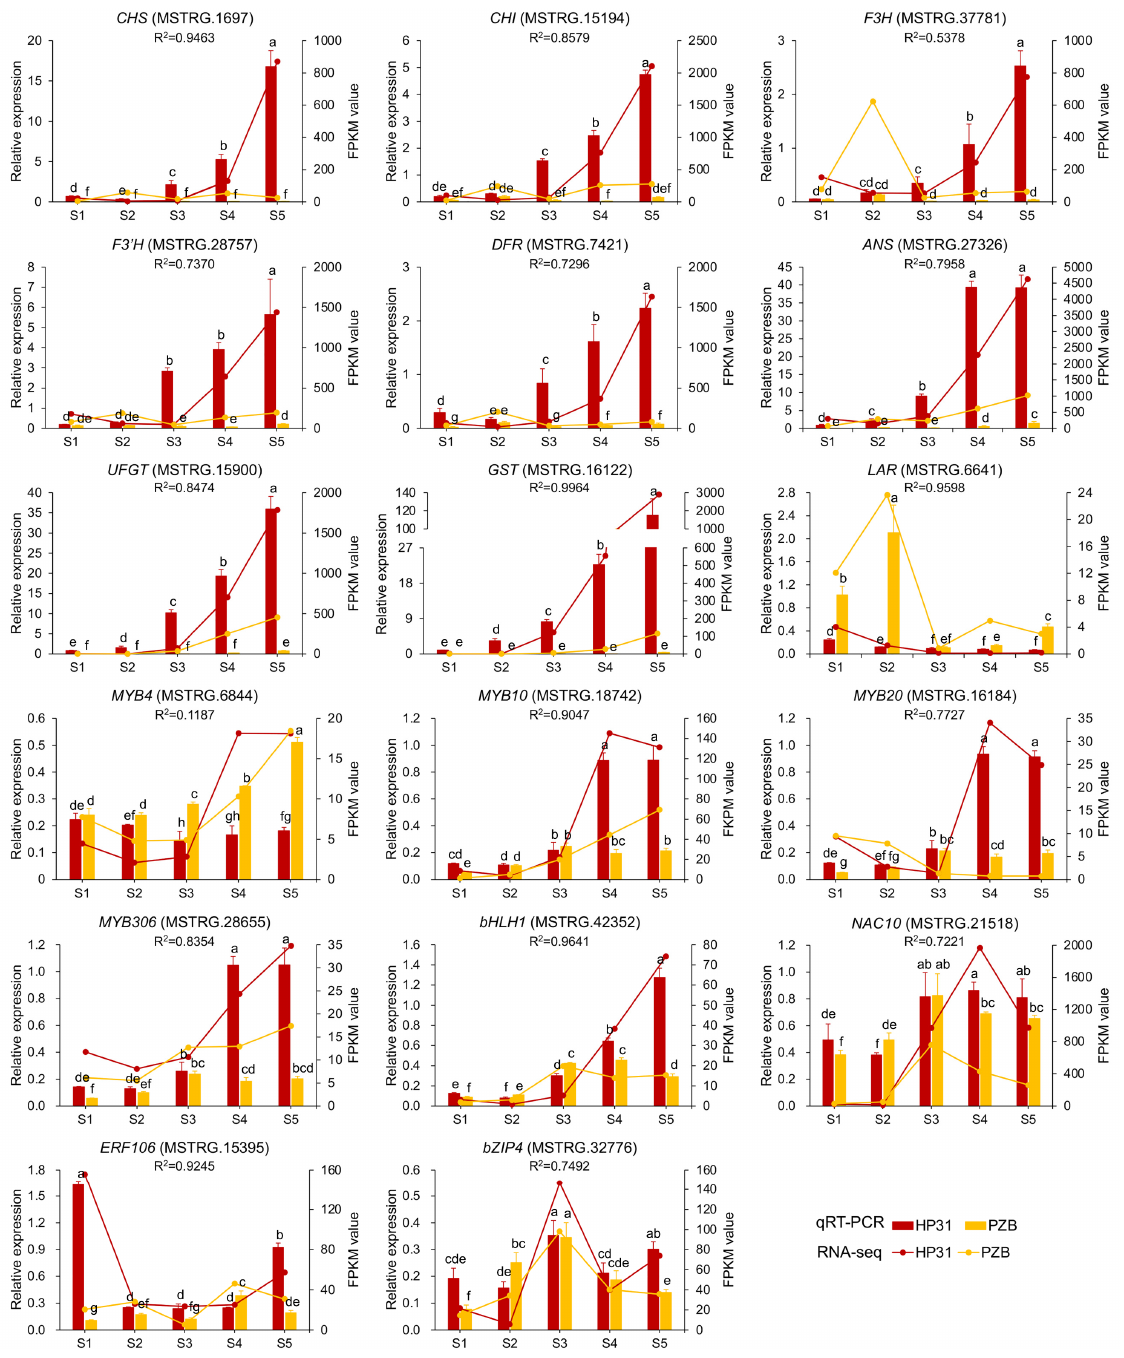
Figure 4. Expression patterns of candidate genes related to anthocyanin accumulation in Chinese cherry during fruit development. Error bars indicated ± SD from three independent replicates. The lower case letter indicated significant difference at 0.05 level for the relative expression level. The ex ‐ pression levels of these genes in ‘HF’ and ‘HP5’ were not shown in this figure.